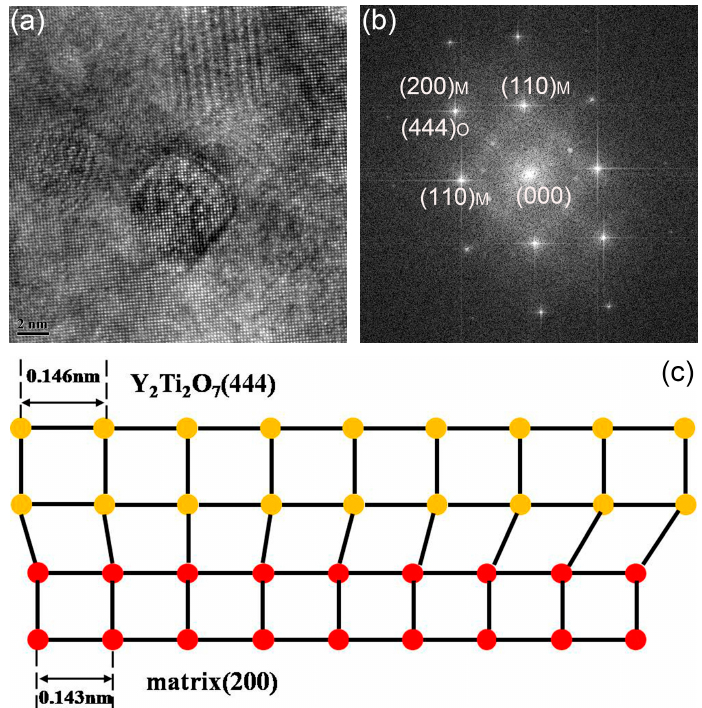
Figure 15. ( a ) HRTEM graph and ( b ) the corresponding FFT pattern of the marked particle in the ODS sample deformed at 1200 ° C with the strain rate of 0.001 s − 1 ; ( c ) schematic diagram of the coherent interface between the marked nanoparticle and matrix.